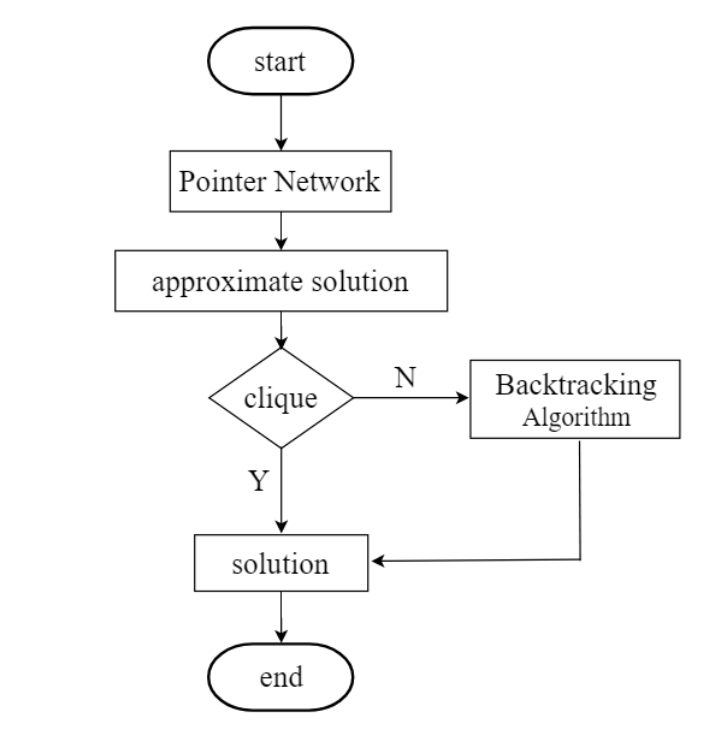
Figure 13. Flowchart of our